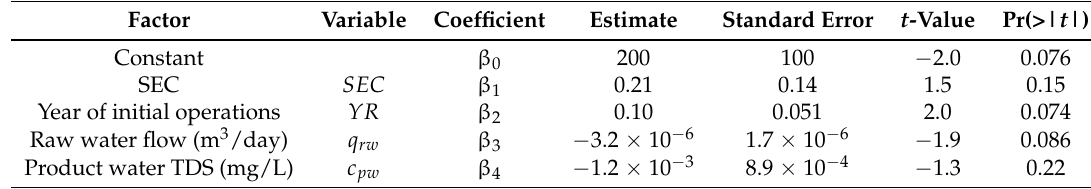
Table A3. Multiple linear regression results for the municipal-scale model of cost of product water ( n = 16) revealed a poor model fit with no significant coefficients. Values have been rounded to two significant figures.